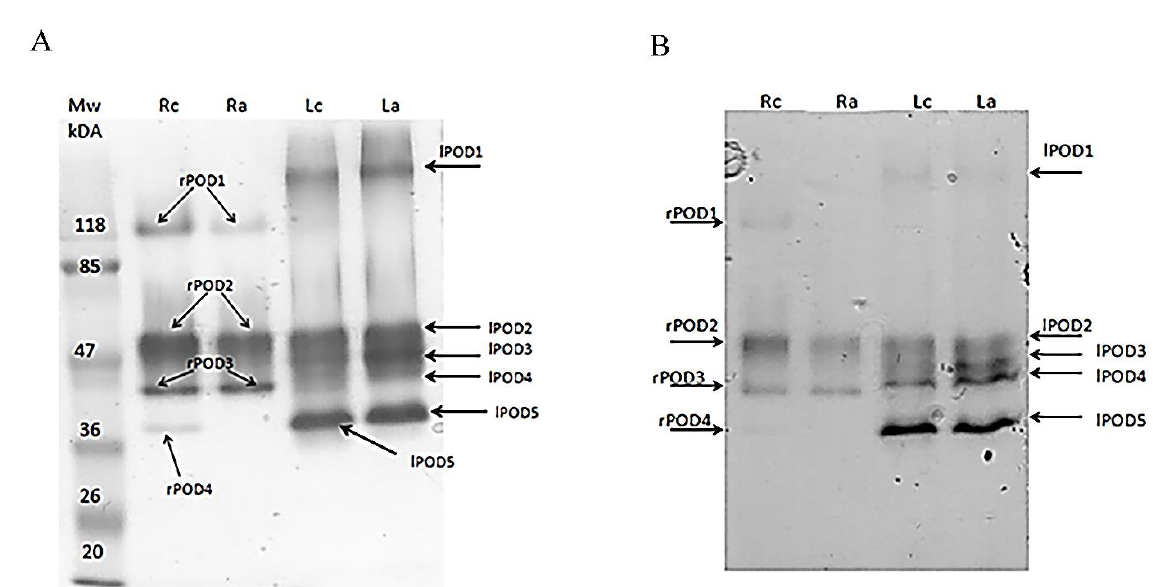
Figure 3. Isoenzyme pattern of POD isoforms detected after: (A) heme staining; (B) staining with α- chloro-naphthol. The molecular weight of standards: β-galactosidase (118 kDA), bovine serum albumin (85 kDA), ovalbumin (47 kDA), carbonic anhydrase (36 kDA), β-lactoglobulin (26 kDA), lysozyme (20 kDA). The arrows indicate the different POD isoforms: in root samples rPOD1, rPOD2, rPOD3, rPOD4 and lPOD1, lPOD2, lPOD3, lPOD4 and lPOD5 in leaf samples. Lc − control leaf; La − ash leaf; Rc − control root; Ra − ash root.